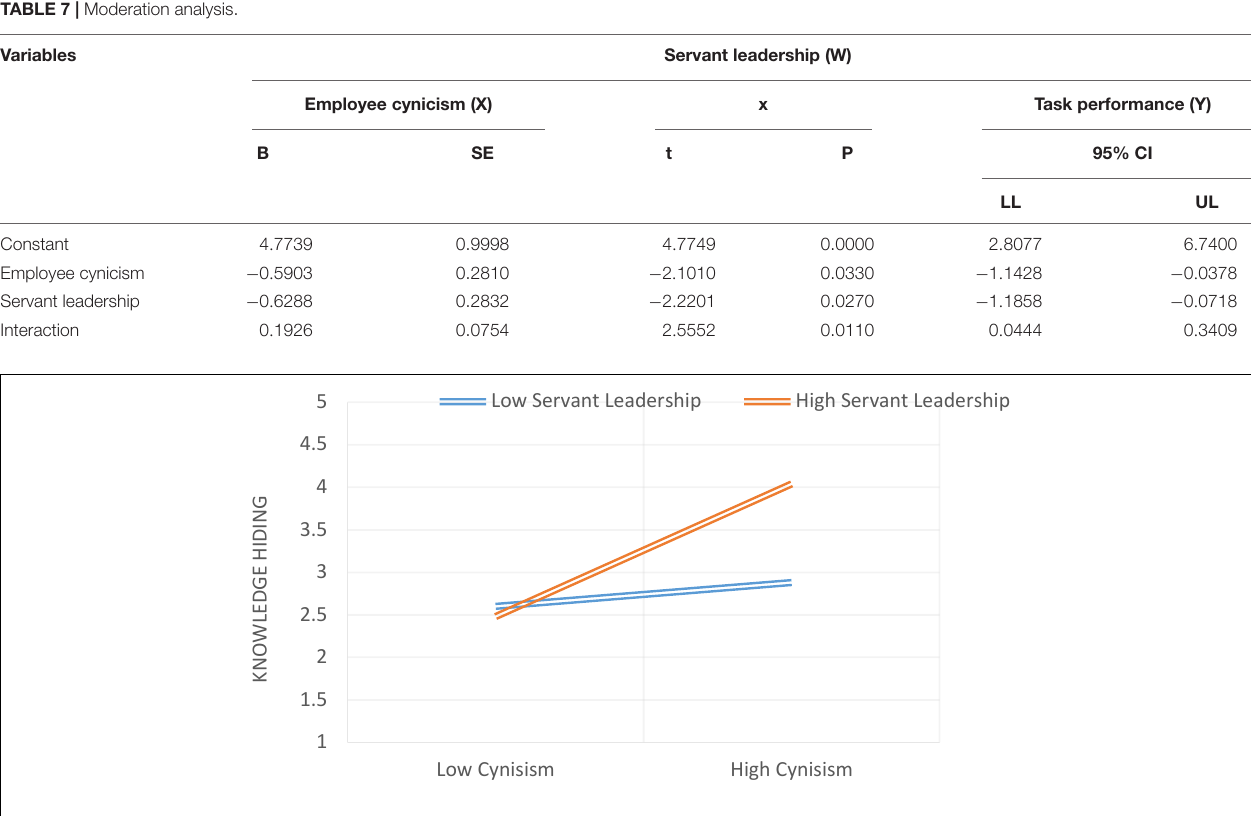
attitudes, i.e., role stress, job insecurity and cynicism.